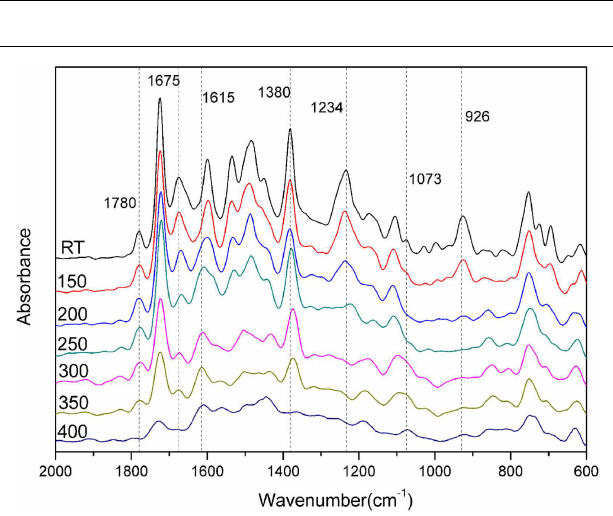
FIGURE 7 | Fourier transform infrared spectra of o AI-a after various thermal treatment